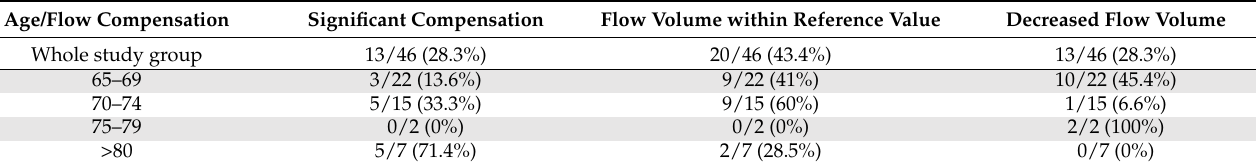
Table 3. Detailed data concerning the flow compensation in different age groups.